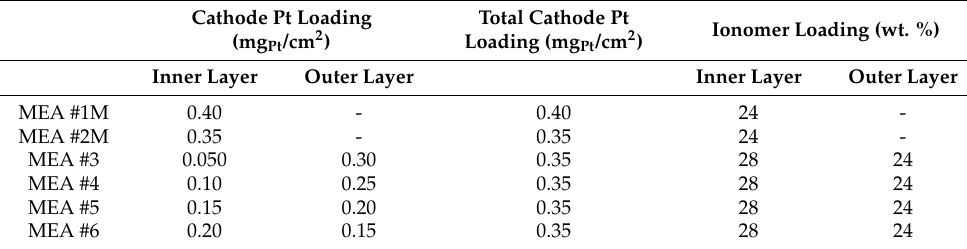
Table 1. Specifications of monolayer and stratified CCL